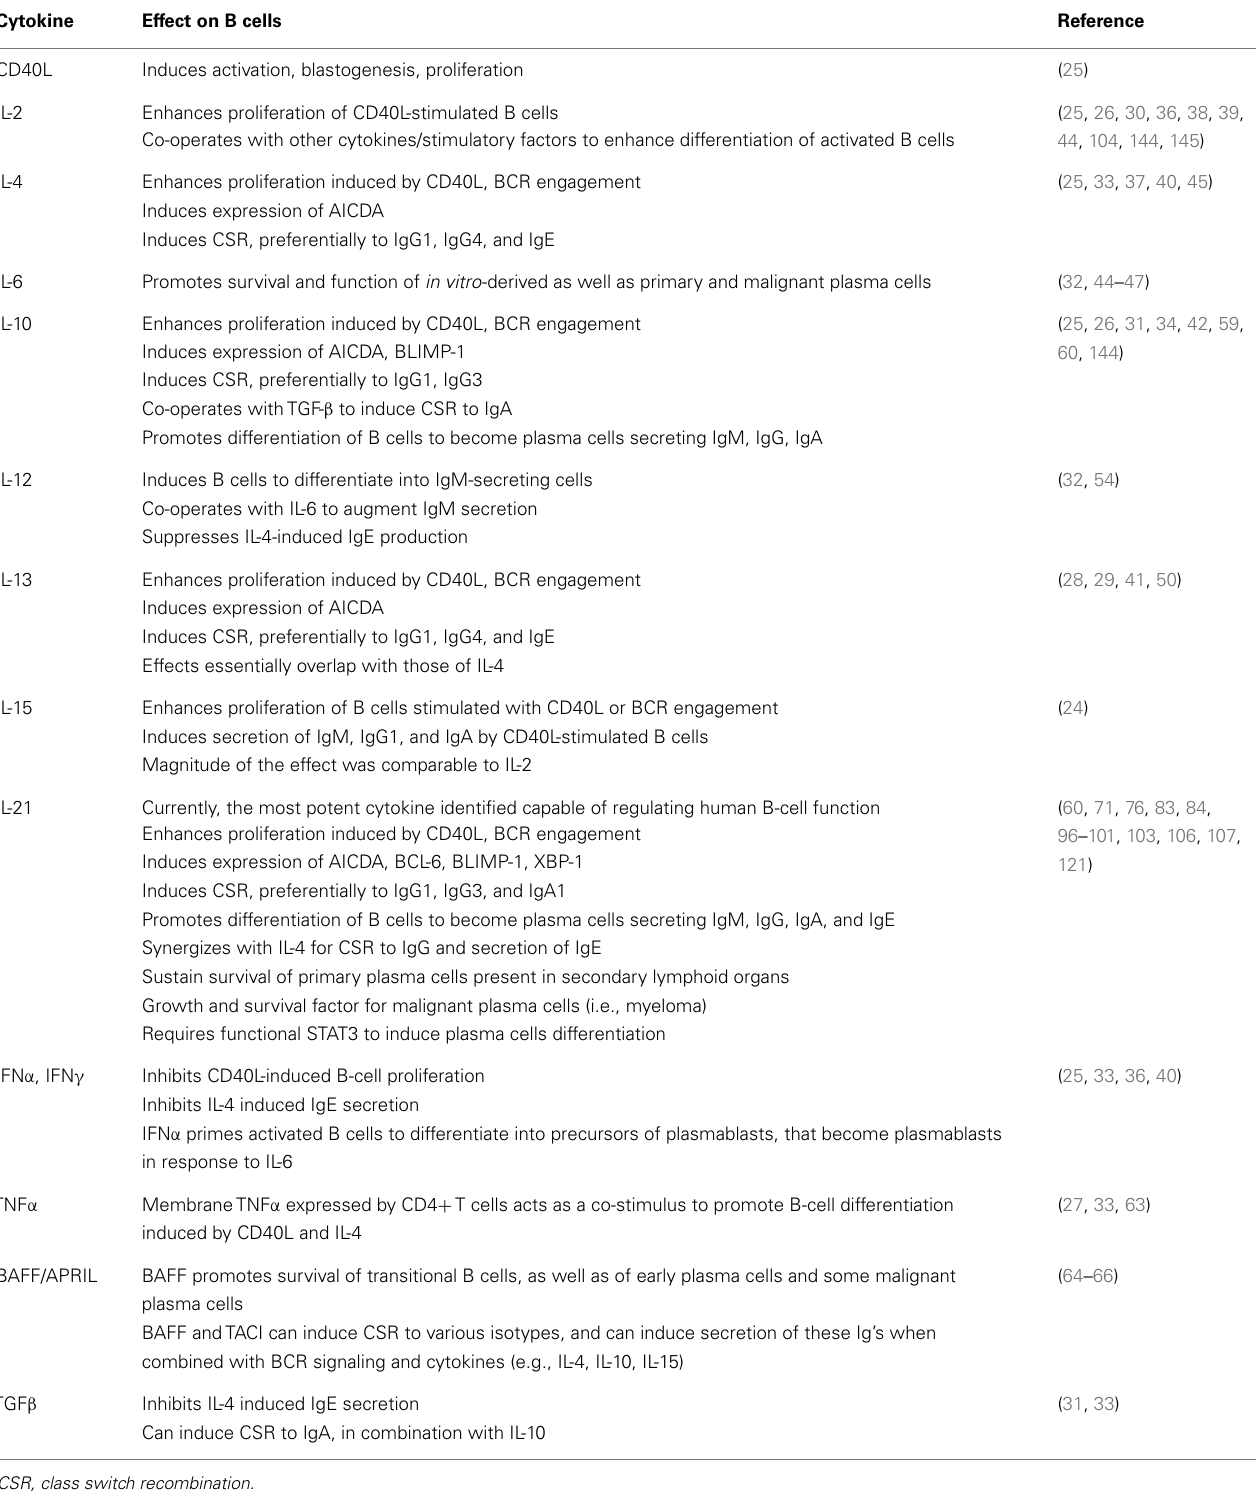
Table 1 | Contribution of different cytokines to the in vitro behavior of human B cells.